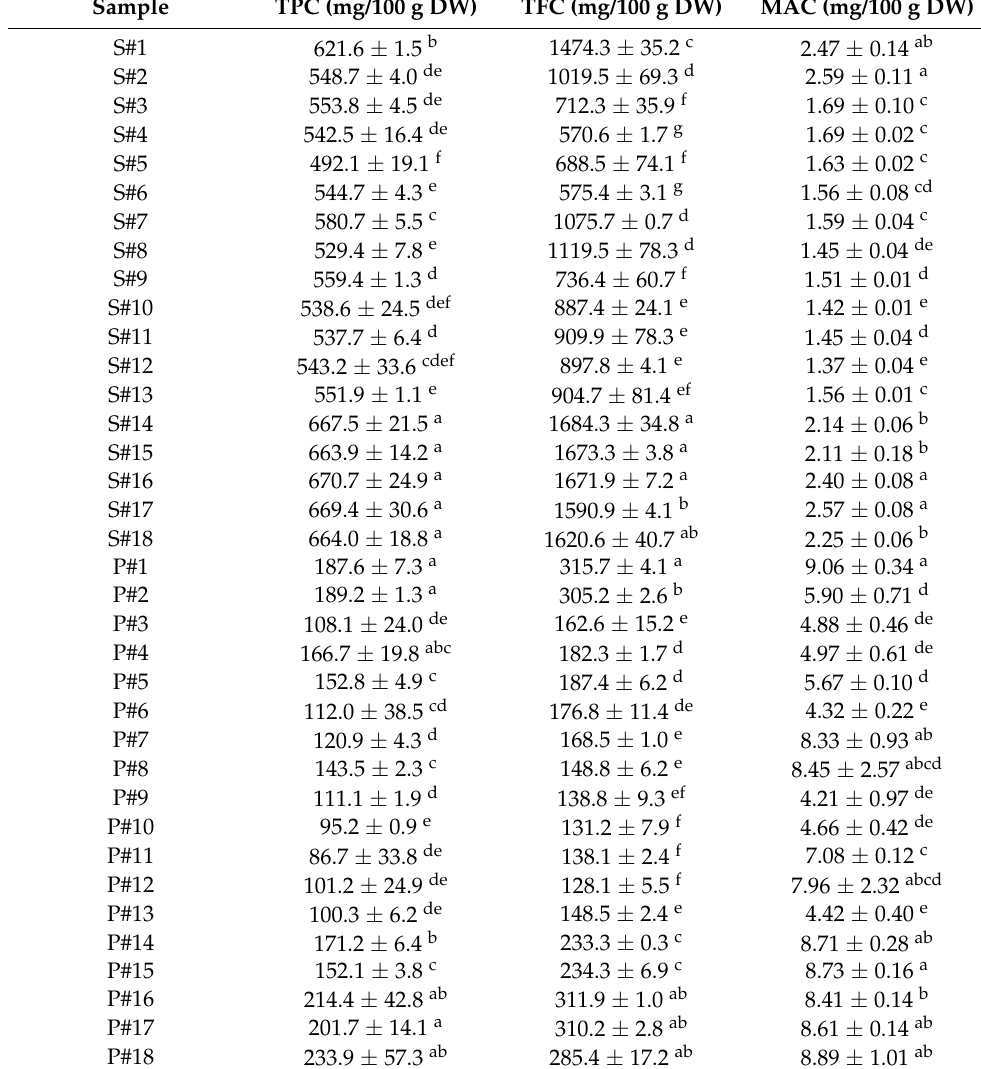
Table 2. Phytochemical profiles of stamen and perianth extracts from 18 N. nucifera populations originating from various floristic regions from